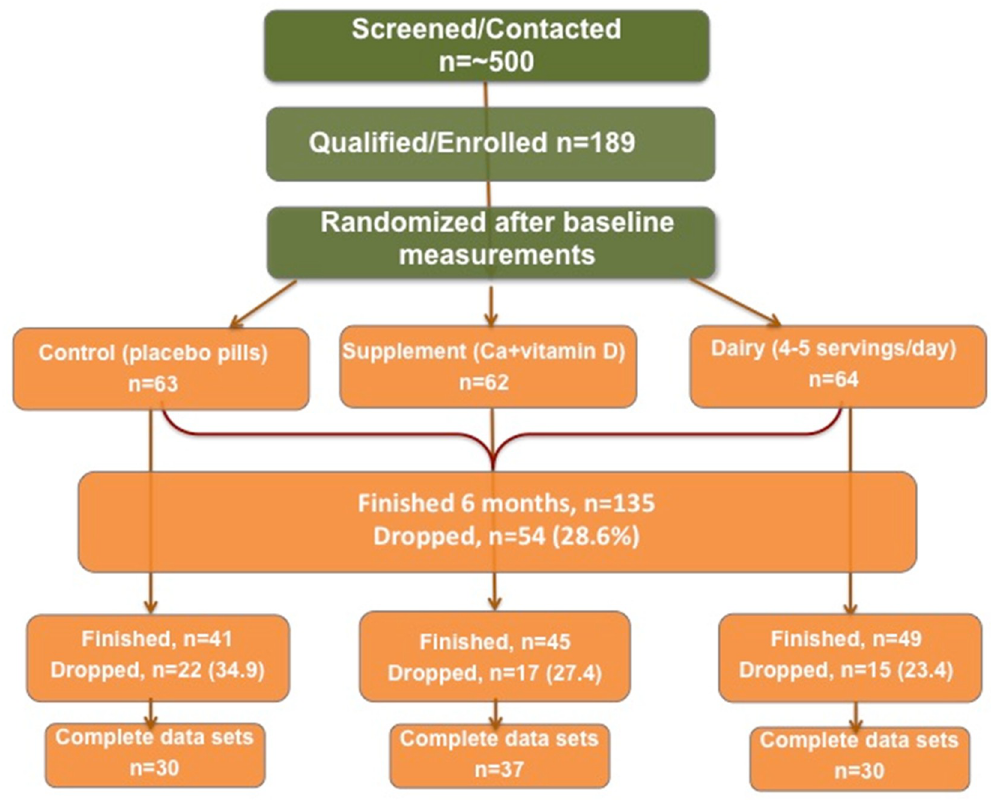
Figure 1. Flow chart of participants’ recruitment, randomization into groups, and attrition.